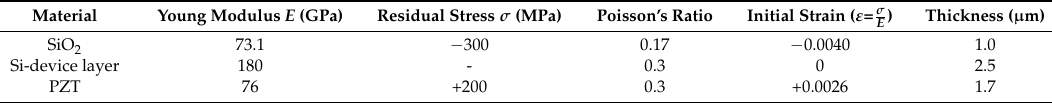
Figure 8. Three-dimensional images of the surfaces for pMUTs ( a ) without and ( d ) with the partial etching of PZT. Profiles along ( b ) A-A’ in ( a ) and ( e ) B-B’ line in ( b ), respectively. Simulation results of the membranes’ deformations ( c ) without and ( f ) with the partial etching of PZT, respectively. Table 1. Material properties and thicknesses used in the residual stress simulation.